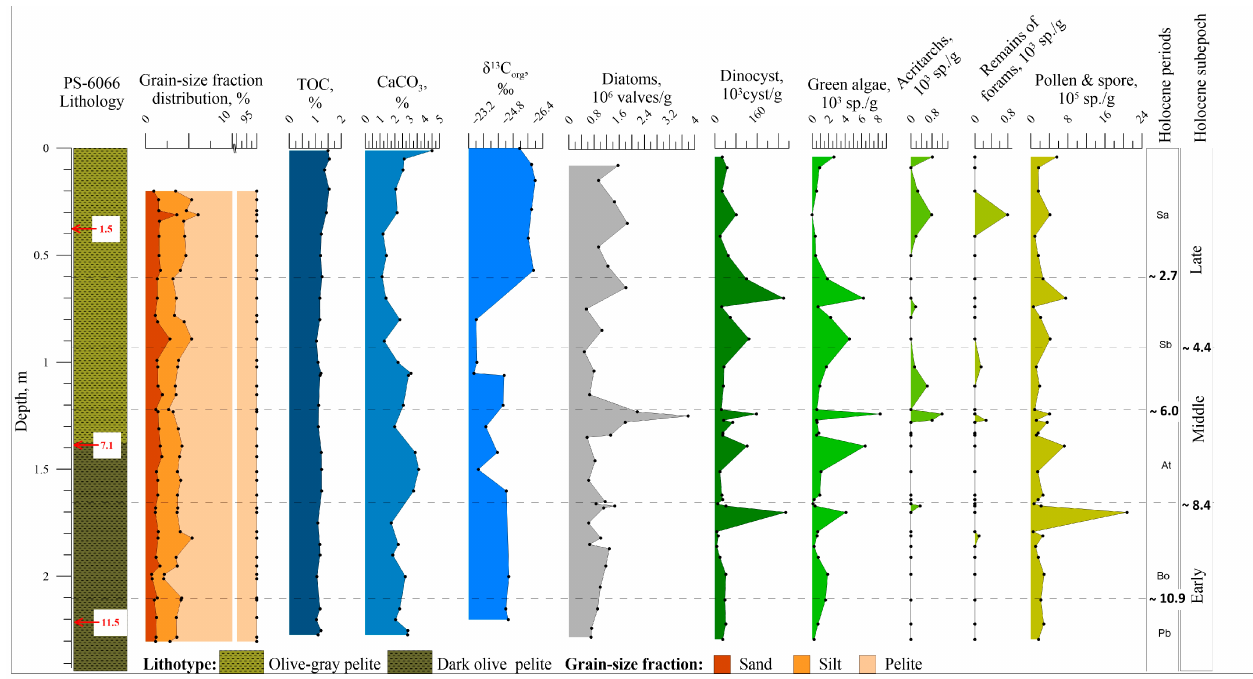
Figure 4. Lithological units; grain size; total organic carbon; calcium carbonate; carbon isotope composition of organic carbon, marked in blue; concentrations of diatoms, marked in gray; dinocysts; green algae; acritarchs; organic foraminifera linings; and pollen and spores (marked in green) expressed in the number of specimens per gram of sediment in core PS-6066, the Kandalaksha Bay. The age model dates in cal kyr BP are marked in red, and the boundary dates in cal kyr BP are